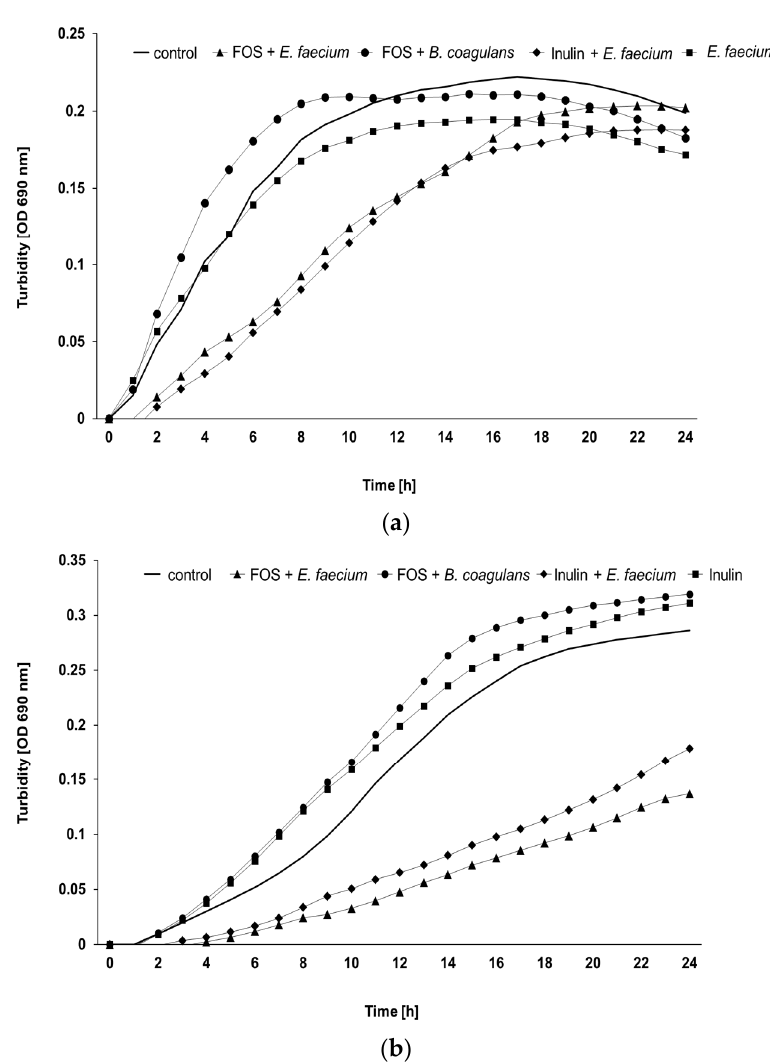
Figure 2. Growth curves presenting the fitness of the pathogenic strains after incubation with different additives in caecal samples from: ( a ) 25 weeks old broiler breeders ( E. coli ) and ( b ) 50 weeks old broiler breeders ( S. Enteritidis) (mean values, n = 15, all farms included FOS = fructooligosaccharides).